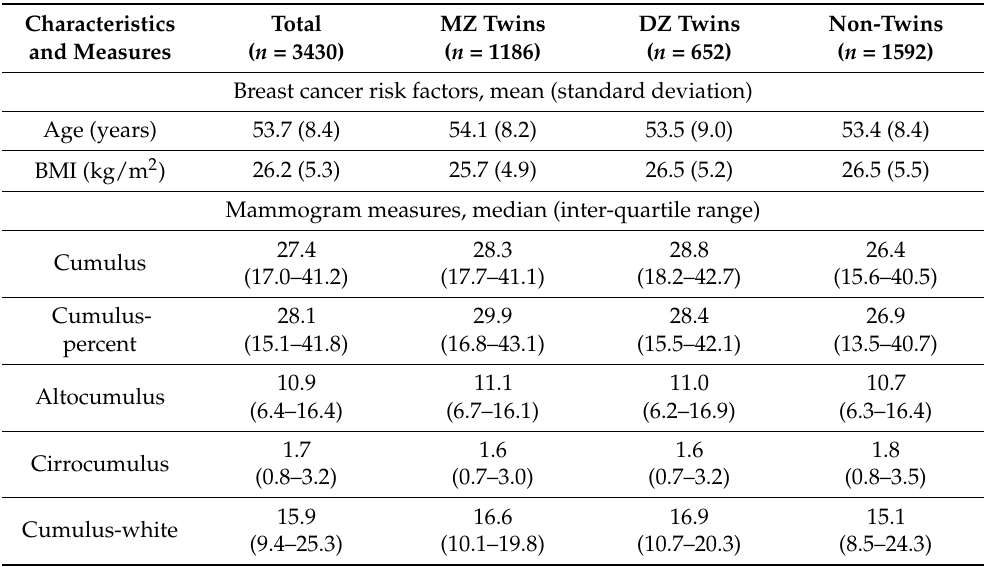
Table 1. Characteristics and measures of study sample by twin status for monozygotic (MZ) and dizygotic (DZ) twins. BMI = body mass